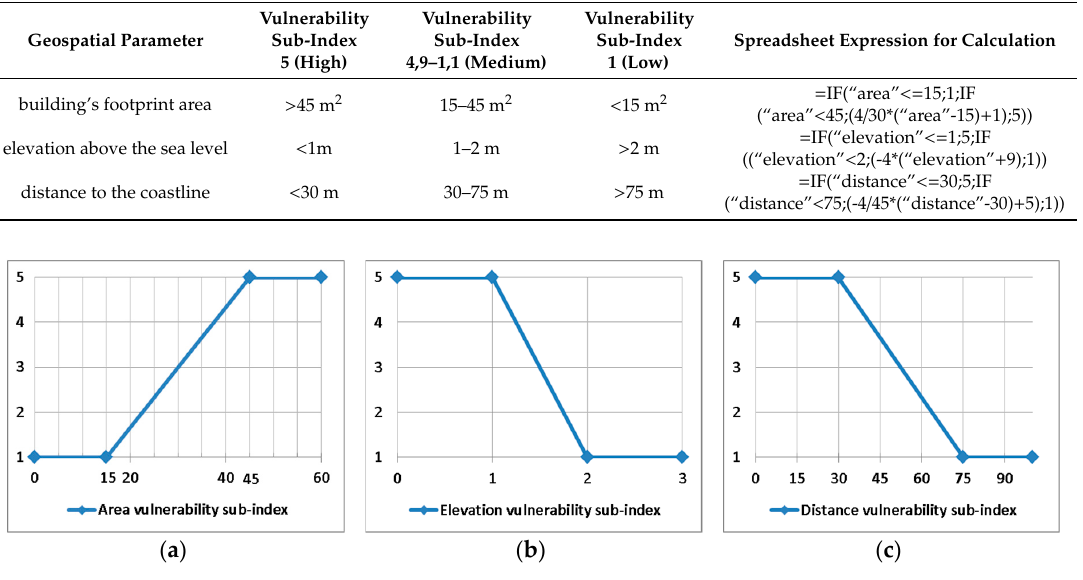
Figure 4. Graphs showing the continuous rankings of the key geospatial parameters—vulnerability sub-indices: ( a ) for the building’s footprint area; ( b ) for the elevation above sea level; ( c ) for the distance to coastline.